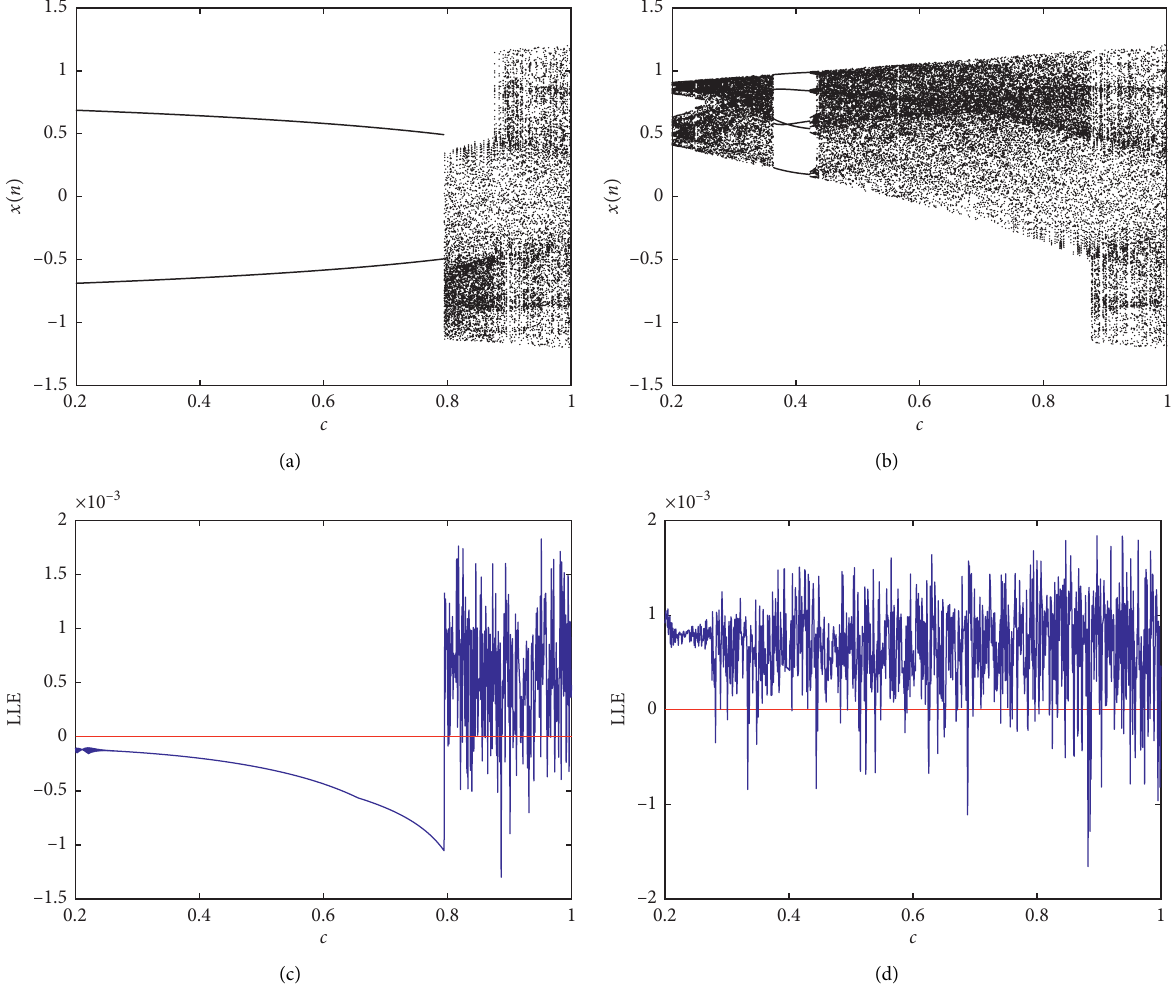
Figure 4: Bifurcation diagrams and corresponding LLE spectrums for the map with different initial values as the parameter c varies: (a) the , (b) the bifurcation diagram with x bifurcation diagram with x 01